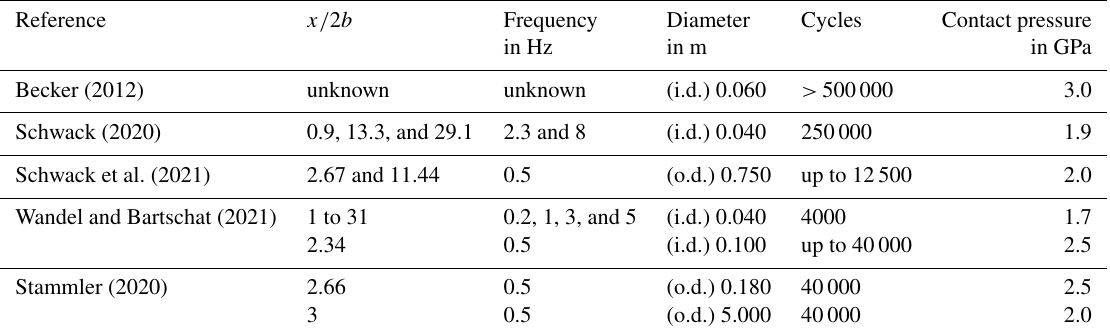
Table 1. Overview of wear tests.